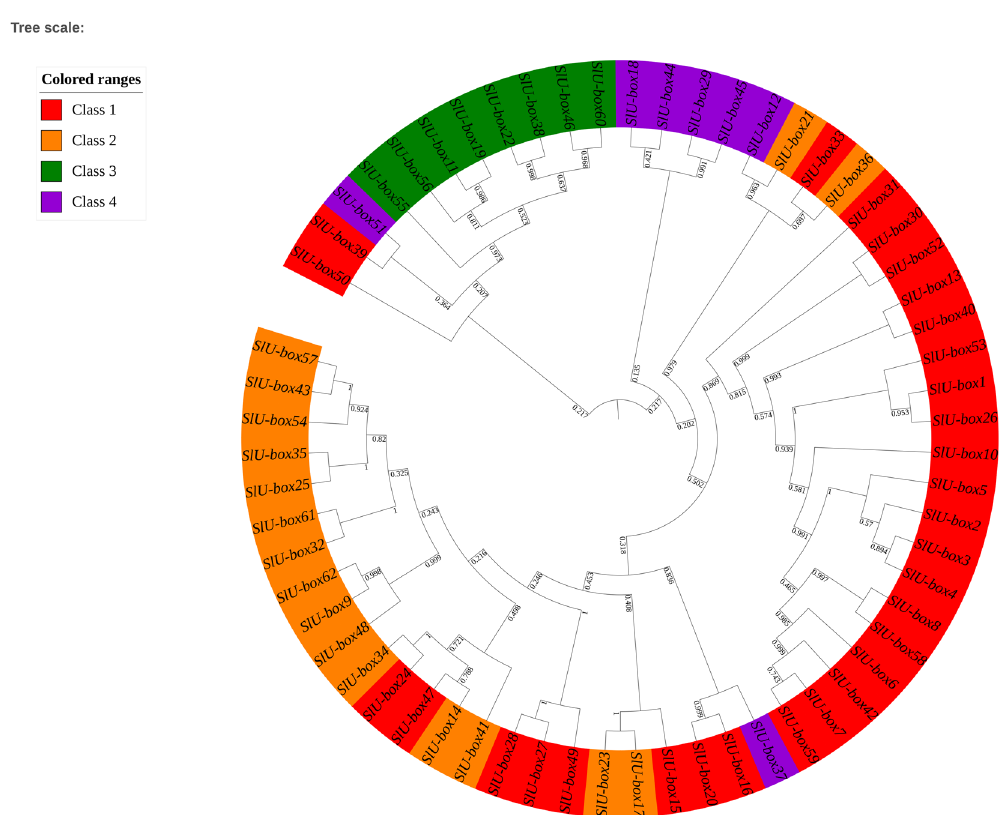
Figure 3. The phylogenetic tree of Solanum lycopersicum U-box E3 ubiquitin ligase gene family members constructed by the Neighbor-Joining method with 1000 bootstrap values. The tomato U-box gene family is divided into four different classes represented by different